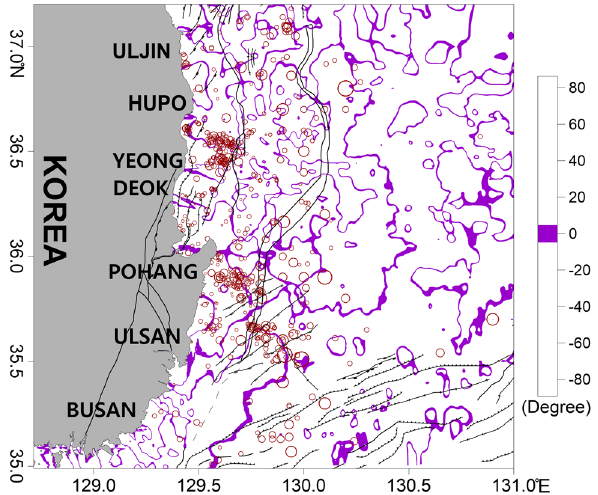
Figure 8. Tilt derivative map of the RTP magnetic anomaly of the study area. Thick purple lines represent contours between 5 and −5°, indicating the boundaries of magnetic source bodies. The major geologic structures and symbols of the earthquakes are the same as those in Fig. 2. This figure was generated using the Surfer software (https:// www. golde nsoft ware.